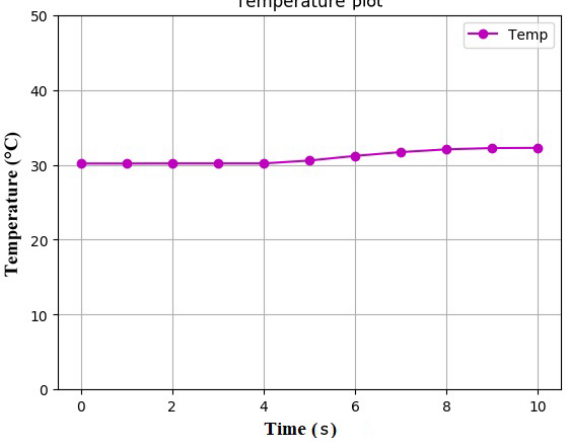
Table 3. Fuzzy water quality for all